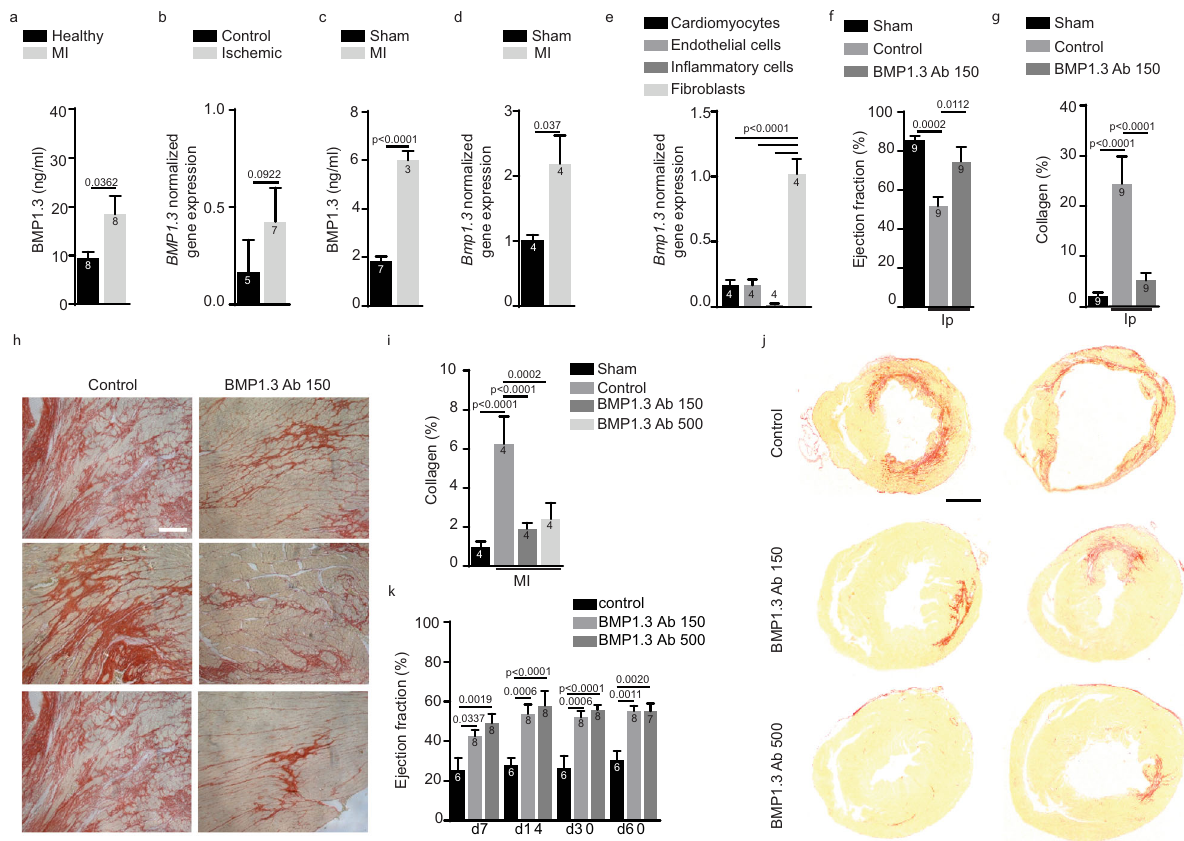
Fig. 1 Therapeutic activity of anti-BMP1.3 antibody after cardiac damage in vivo. a Quanti fi cation of BMP1.3 protein levels in blood of healthy individuals and patients affected by acute myocardial infarction (MI) within 12 h from hospitalization. b Quanti fi cation of the expression levels of BMP1.3 normalized over GAPDH in human myocardium of patients without overt cardiac disease (control) or affected by ischemic heart disease (ischemic). c Quanti fi cation of BMP1-3 protein levels in the blood of sham-operated or infarcted mice at 24 h after MI. d Quanti fi cation of the expression levels of Bmp1.3 normalized over 18 S in the myocardium of sham-operated or infarcted mice at 48 h after MI. e Quanti fi cation of the levels of Bmp1.3 mRNA normalized on Actb in different cardiac cell types at 48 h after MI. f Quanti fi cation of the ejection fraction in rats treated with isoproterenol (Ip), alone (control) or in combination with anti-BMP1.3 antibody (150 µ g/kg). Values for sham animals are also shown for reference. g Quanti fi cation of the area covered by collagen in each section. h Representative images of heart sections stained with Sirius red to show collagen deposition upon administration of isoproterenol alone (control) or in combination with anti-BMP1.3 antibody. i Quanti fi cation of the area covered by collagen in sections of murine hearts sham-operated or injured by myocardial infarction (MI) and treated with the indicated dose of anti-BMP1.3 antibody (150 or 500 µ g/kg). j Representative images of murine heart sections stained with Sirius red to show collagen deposition upon MI and treatment with the indicated dose of anti-BMP1.3 antibody. k Quanti fi cation of the ejection fraction at 7, 14, 30, and 60 days after MI. Data in a , b , c , d , e , f , g , i , and k are shown as mean ± s.e.m. Sample number is indicated inside or above each bar. Statistical signi fi cance was determined using unpaired, two-sided t -test in a – d , one-way ANOVA, followed by Tukey ’ s test in e , f , g , i , and two- way ANOVA in k followed by Tukey ’ s multiple comparison test. Scale bar in h , j is 200 µ m and 1 mm, respectively. Source data are provided as a Source Data fi described in Supplementary Fig. 2a, starting at 2 h after kg) dose, according to the protocol shown in Supplementary isoproterenol administration. Isoproterenol injection resulted in Fig. 2a. Morphometric and histological analysis at 2 months after pronounced increase in circulating troponin T levels, with a peak MI showed a signi fi cant deposition of fi brotic tissue in the left at day 1 and persisting up to day 3 after the last administration ventricle (LV) of control animals, as expected (Fig. 1i, j). (Supplementary Fig. 2b). Rats that received the anti-BMP1.3 Treatment with any dose of anti-BMP1.3 antibody signi fi cantly reduced scar size (Fig. 1i, j), in line with data obtained in the rat model. Cardiac function was monitored by echocardiography up to 2 months. The main parameters of cardiac function, ejection fraction and fractional shortening, were signi fi cantly higher in animals treated with either dose of the anti-BMP1.3 antibody compared to control animals at all time points (Fig. 1k and Supplementary Fig. 2c). Accordingly, additional indexes of cardiac function, including LV end-systolic and end-diastolic diameters (LVIDs and LVIDd), LV systolic and diastolic anterior wall thickness (LVAWs and LVAWd) and LV anterior wall thickening were all improved in mice treated with the anti- BMP1.3 antibody (Supplementary Fig. 2d – h).